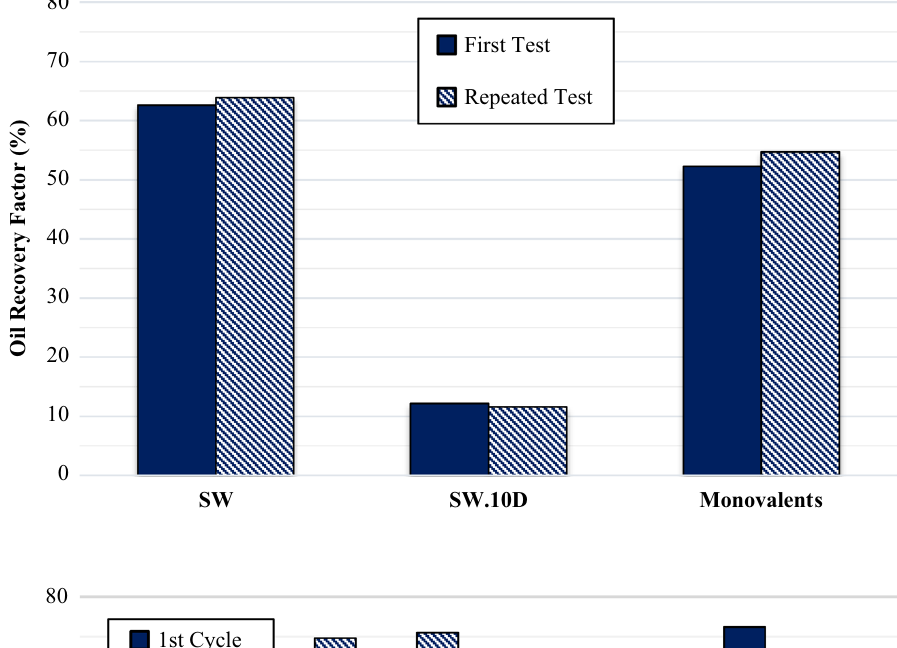
Fig. 4 Graphical overview of performed scenarios at 90 °C. The dashed parts show addi- tional oil recovery in the second cycle of smart water